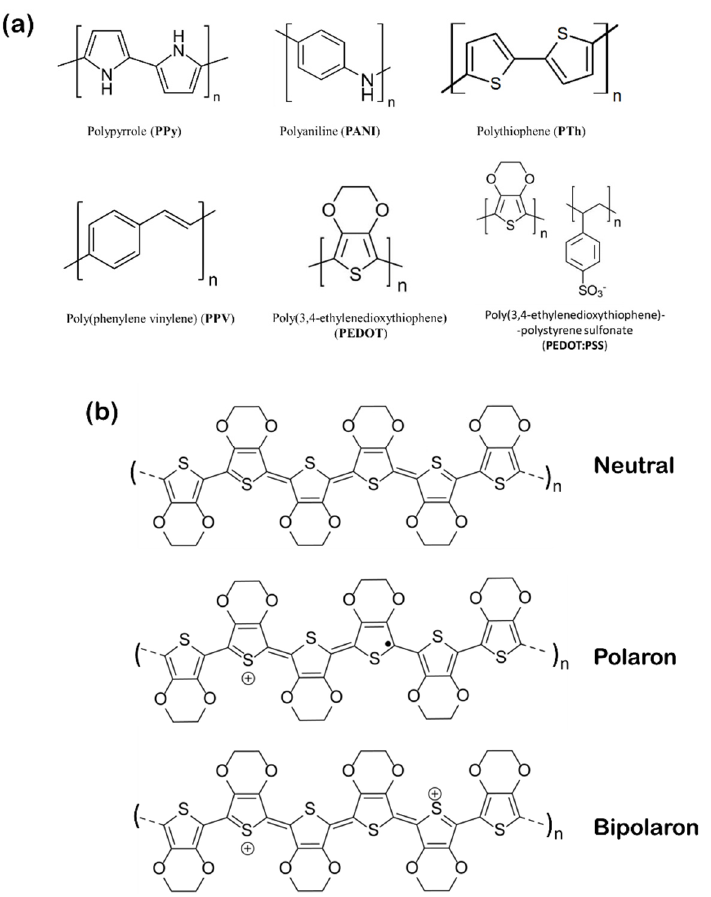
Figure 12. ( a ) Chemical structures of the most representative conducting polymers used in gas-sensing devices and ( b ) chemical structure of PEDOT neutral chain, polaron (a radical cation charge carrier), and bipolaron (a di-cation charge carrier).